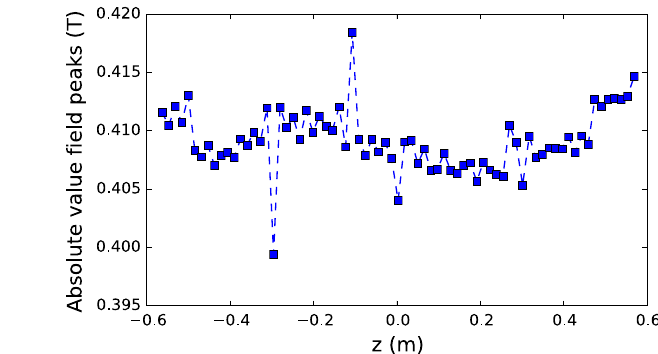
FIG. 31. Vertical and horizontal measured phase errors as a function of magnet current. FIG. 32. Vertical field peaks of the HSCU at 450